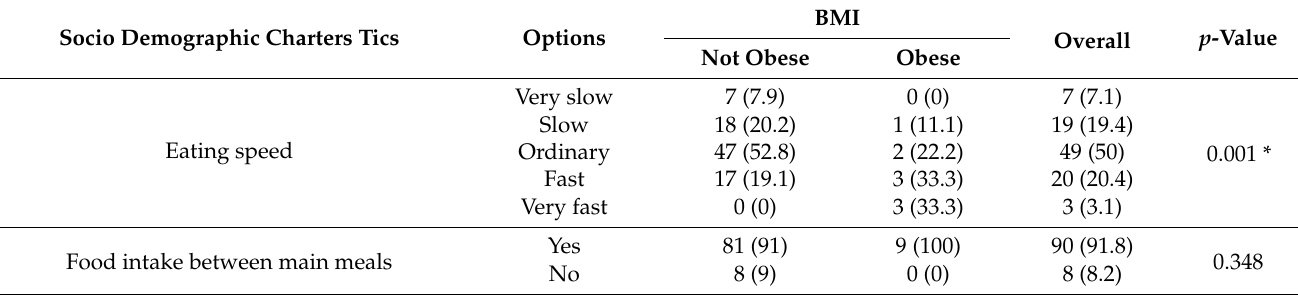
Table 5. Association between sociodemographic characteristics and